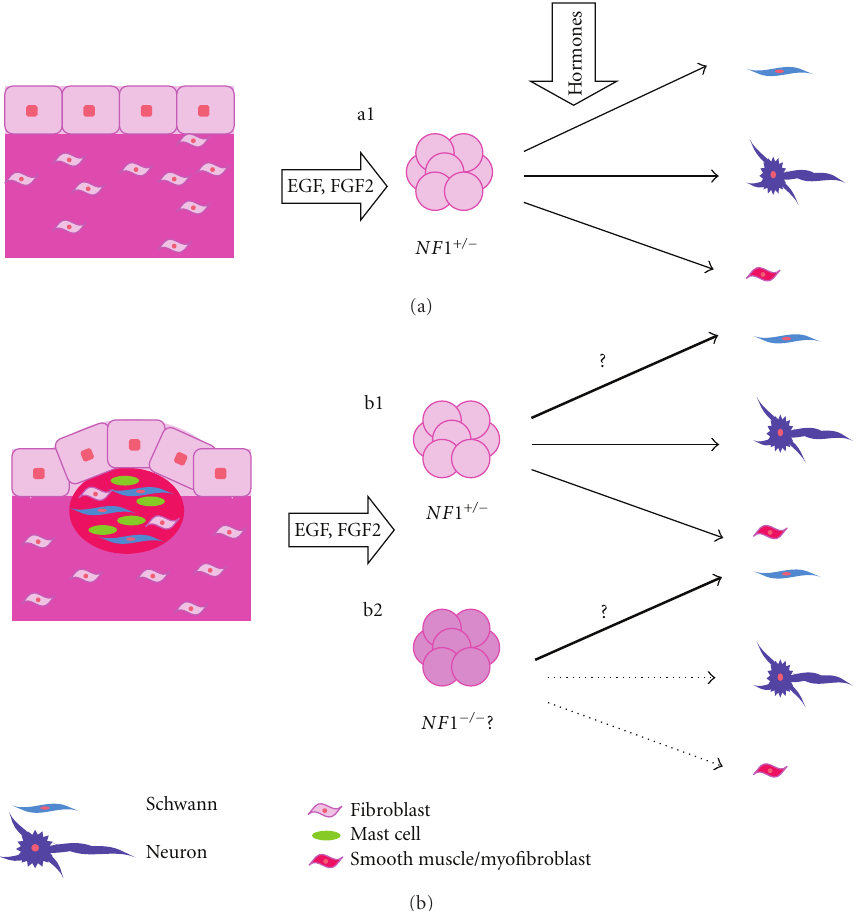
Figure 2: Isolation of SKPs from healthy skin and a neurofibroma of an NF1 patient. (a) Dermal multipotent stem cells form spheres in vitro, in response to EGF and FGF. In NF1 patients, SKPs from healthy skin should give rise to NF1 + / − SKPs in vitro (a1). SKPs can di ff erentiate into glial, neuronal, and mesodermal lineages. If SKPs are isolated from NF1 patient neurofibromas, NF1 + / − SKPs (b1) are expected to form in vitro, under standard culture conditions. If NF1 − / − (b2) SKPs may be isolated has to be determined. If SKPs are the cell of origin of neurofibromas, they might present a predisposition to di ff erentiate into the glial lineage.